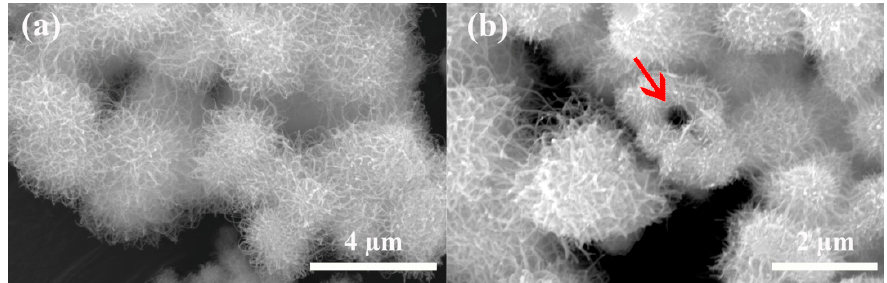
Figure 2. ( a ) SEM images of the as-prepared WO 3 ; ( b ) SEM images of the as-prepared WO 3 showing a hollow structure through the broken sphere (red arrow).